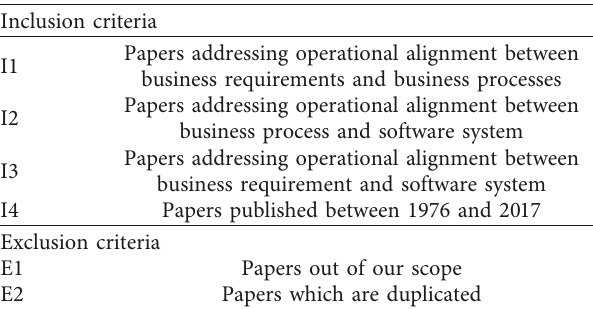
Table 2: Inclusion and exclusion criteria. Inclusion